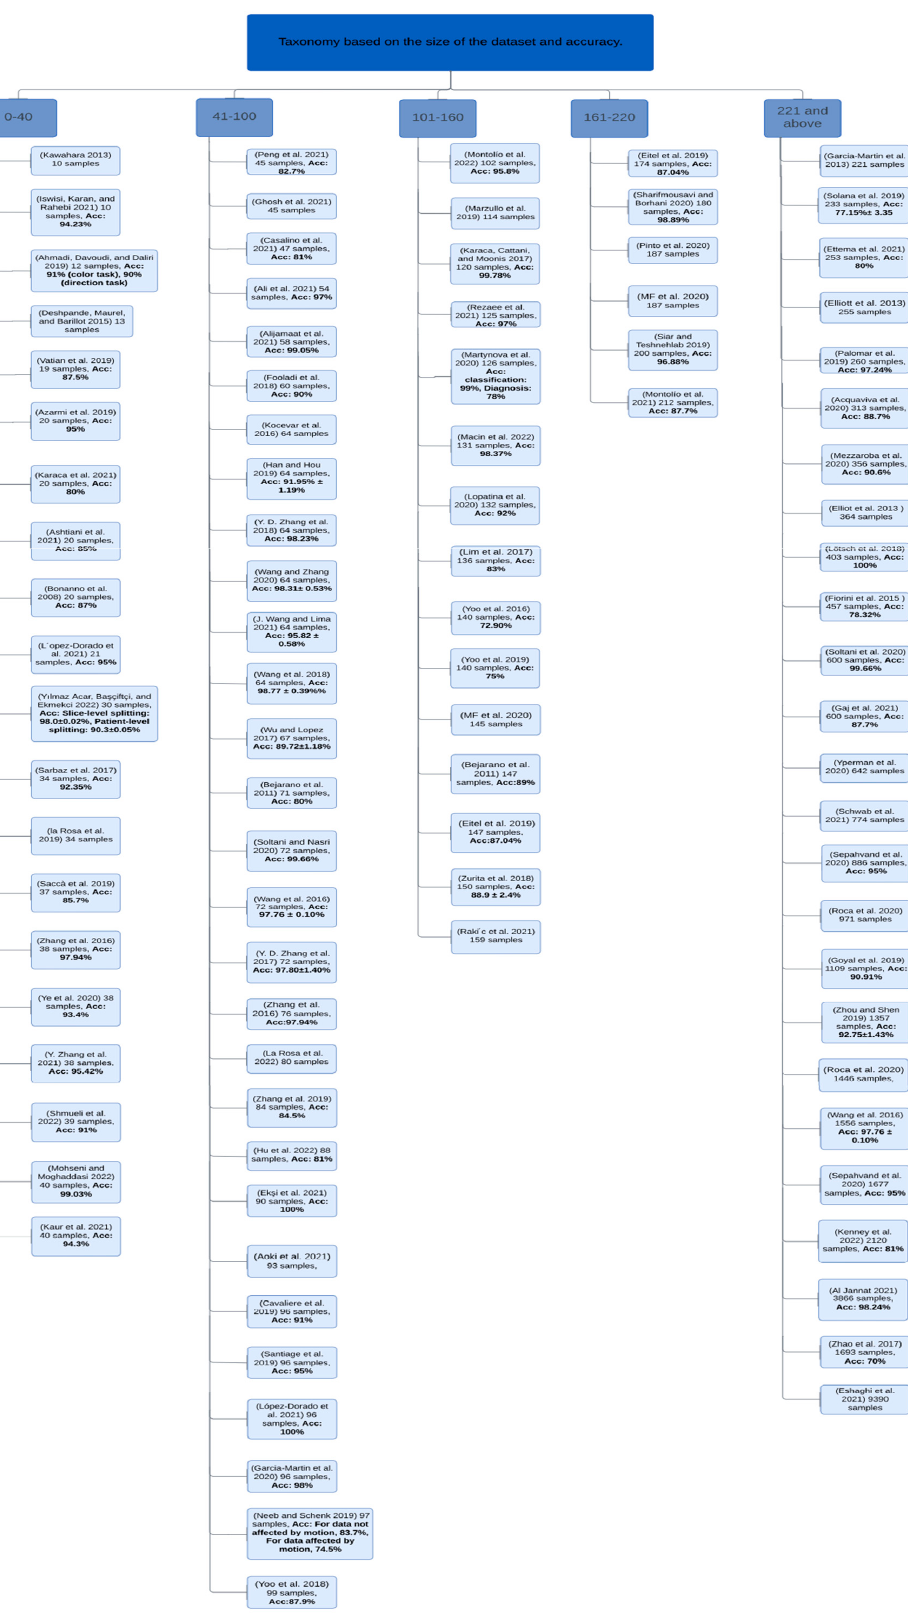
Figure 3. Taxonomy of studies based on dataset and